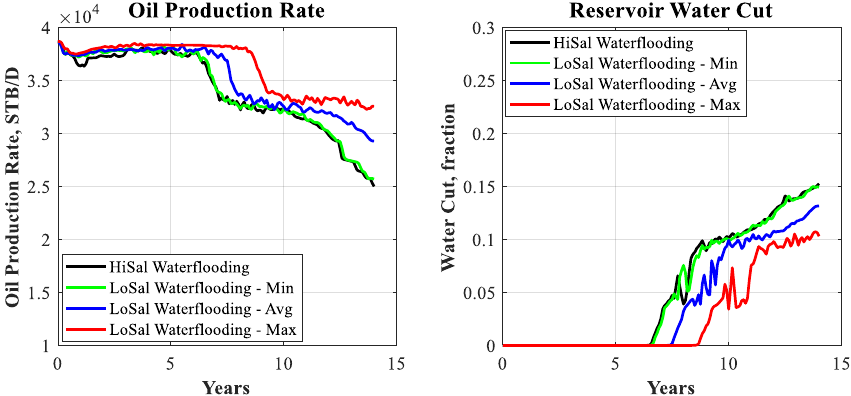
Figure 14. Comparison of the waterflooding scenarios using high salinity and low salinity schemes in the Qamchuqa reservoir, using the exponential weighting factor.